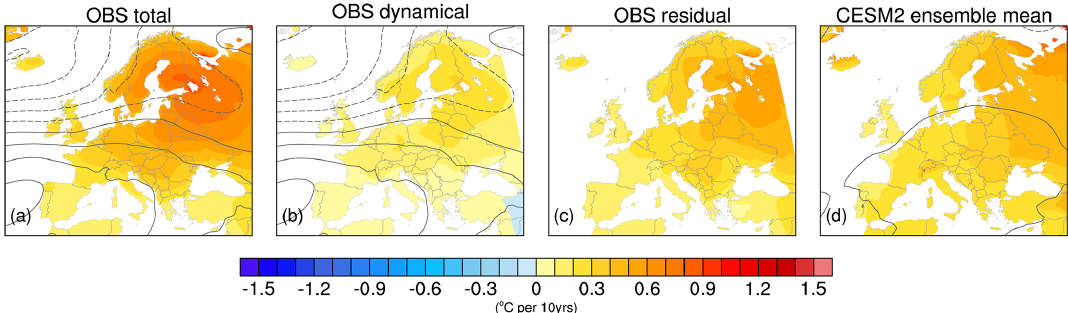
Figure 12. Decomposition of (a) observed winter air temperature trends (1962–2021; ◦ C per decade) into (b) dynamical and (c) residual thermodynamic contributions, using the dynamical adjustment procedure of Deser et al. (2018), based on constructed circulation analogues (see text for details). Contours in panel (a) show observed sea level pressure (SLP) trends (contour interval of 0.25hPa per decade; negative values dashed), contours in panel (b) show the observed SLP trends estimated from the constructed circulation analogues, and contours in panel (c) , based on the difference between panels (a) and (b) , are near zero and not shown. Panel (d) shows the ensemble-mean temperature and SLP trends from the 100-member CESM2 large ensemble (note that only the zero contour shows up in panel d ).